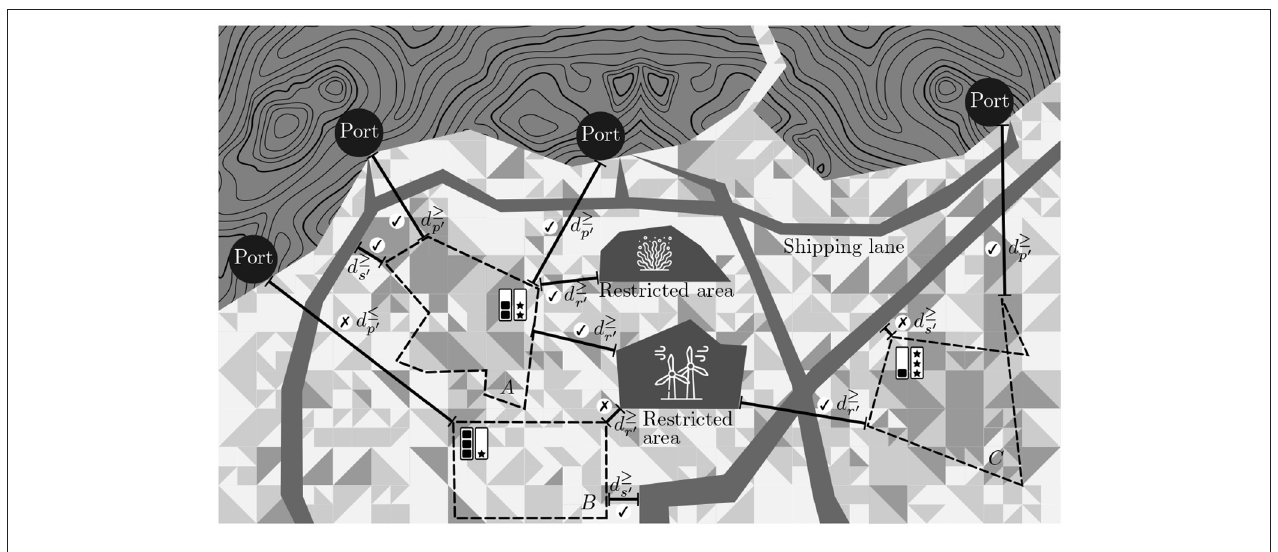
FIGURE 2 | Problem